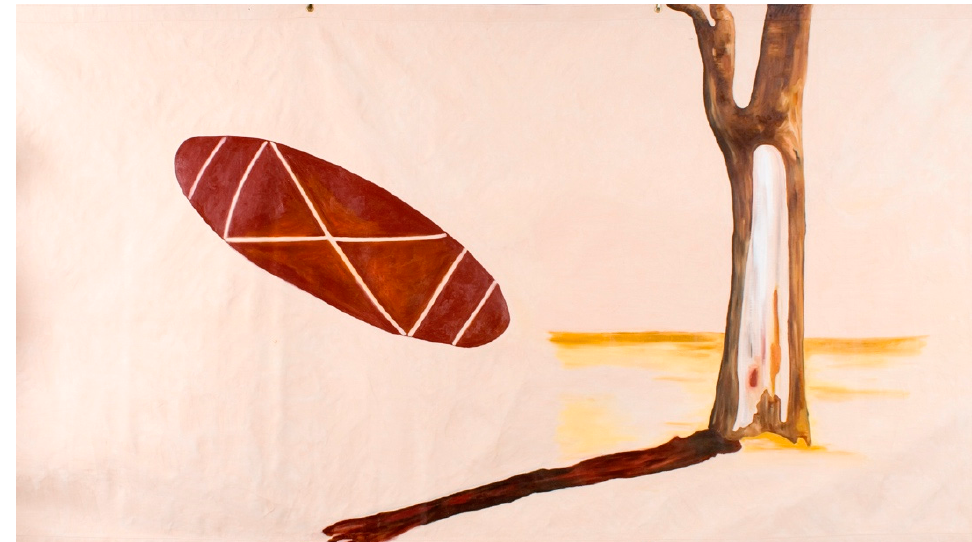
Figure 14. Fiona Foley Scar Tree (2000). Oil on Canvas. Showing the trunk of a tree in southern Queensland that has a scar from where bark was taken to build a shield, Foley protests the Hervey Bay City Council’s decision to tear down a tree that was a living example of the Badtjala Nation’s connection to their land.